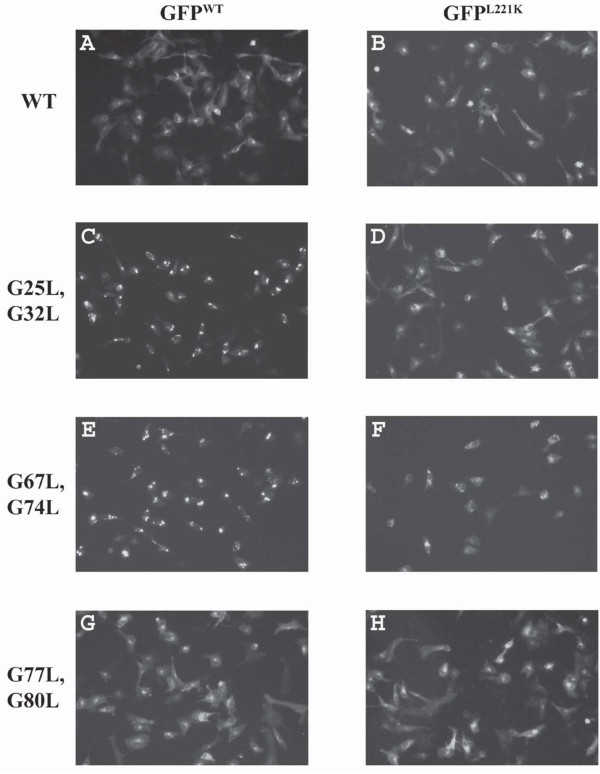
Expression of wild-type and mutant CD9 TM(1+2)-GFP proteins in human cells. Human rhabdomyosarcoma RD cells were transfected with constructs encoding CD9 TM(1+2)-GFP fusion proteins that carried mutations indicated. Either wild-type or monomeric (L221K) GFP was used. Images were captures 18–28 hours post-transfection.